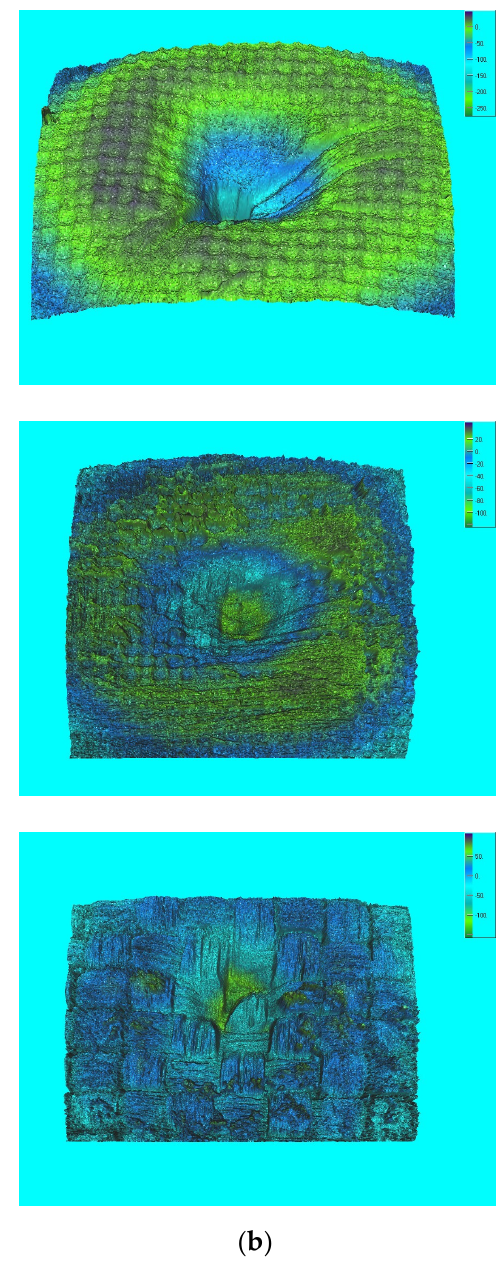
Figure 10. Eroded surface view for 15k samples: ( a ) microscopic view and ( b ) 3D surface profilometer image.